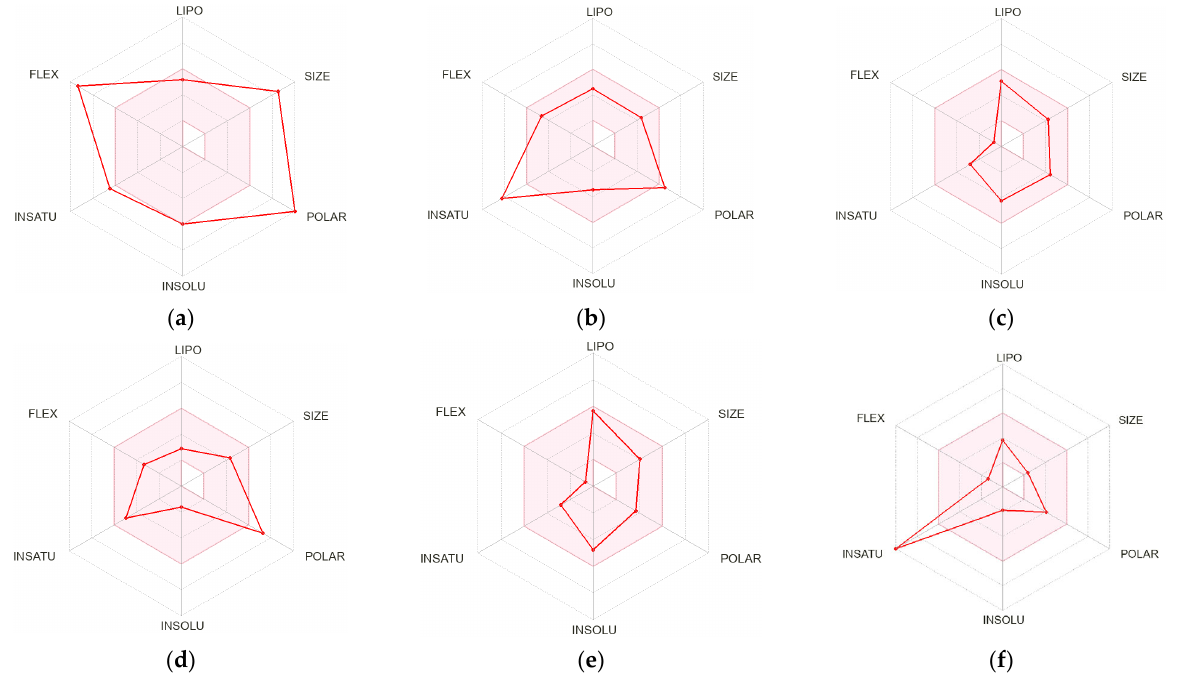
Figure 5. The pink area of the bioavailability radar represents the optimal range for each property. Bioavailability radars of sagerinic acid ( a ), rosmarinic acid ( b ), rosmanol ( c ), chlorogenic acid ( d ), carnosol ( e ), and caffeic acid ( f ) were obtained.